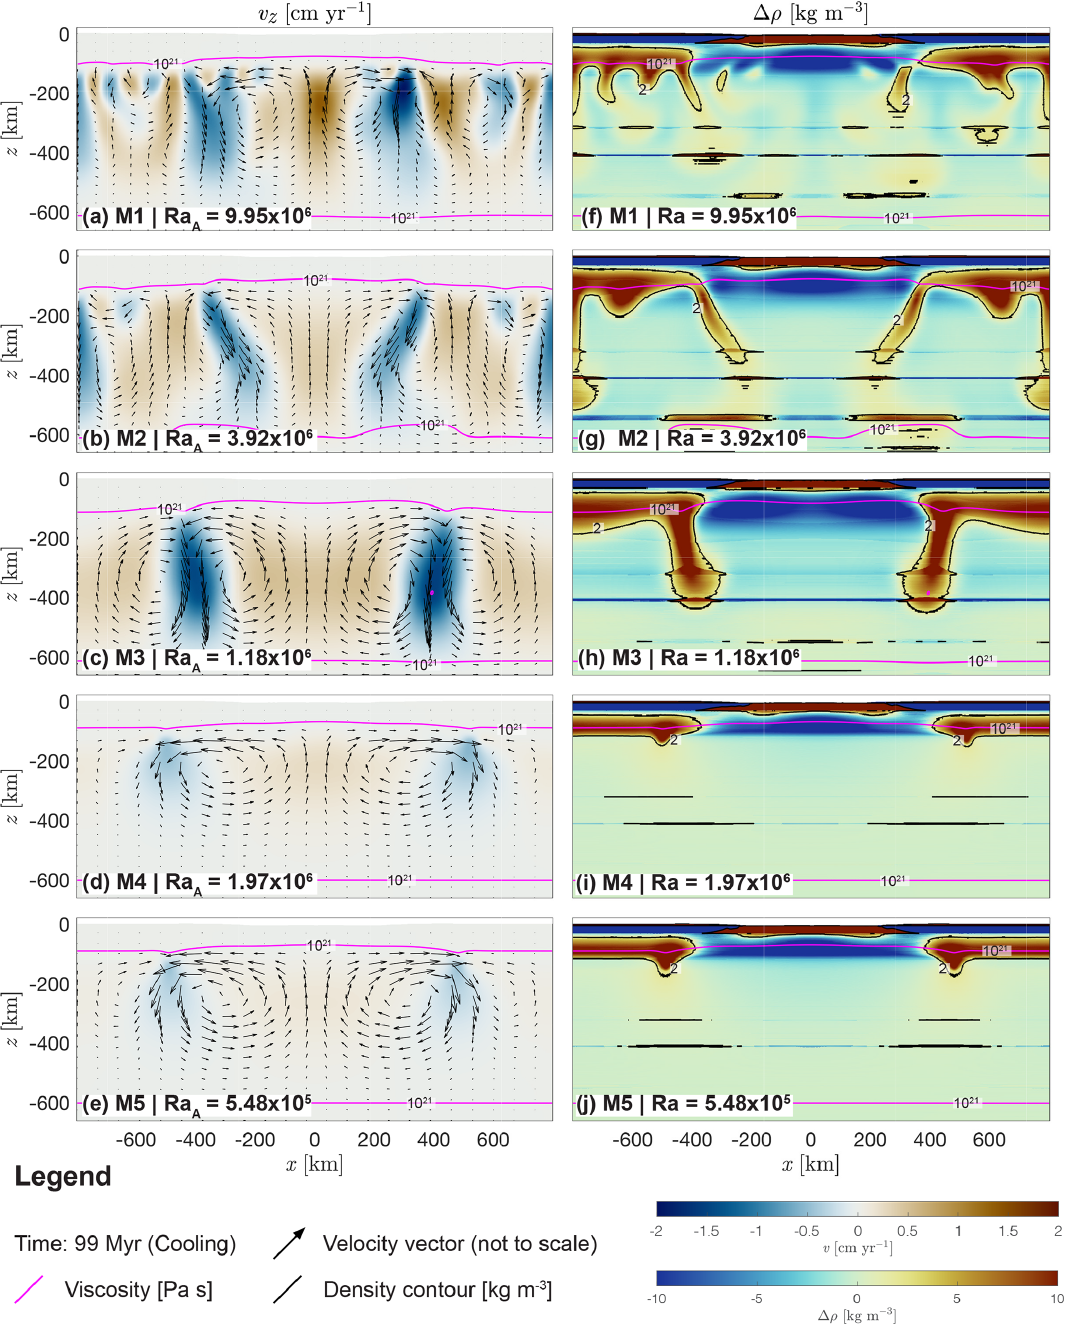
Figure 6. Results of models M1–5 at 99Myr (end of cooling period). (a–e) Blue to red colours indicate the vertical velocity magnitude calculated by the numerical algorithm. Black arrows velocity vectors show (not to scale) to visualize the material flow field. (f–j) Blue to red colours indicate the difference between the entire density field and the horizontal average density profile as shown in Fig. 2e. Black lines are the 2kgm − 3 density contour. The magenta line shows the level of the 10 21 Pas viscosity isopleth in all subfigures. This contour line represents the mechanical boundary between the rigid mantle lithosphere (no velocity glyphs) and the convecting upper